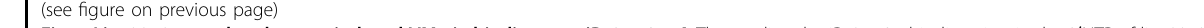
Fig. 5 Linc00707 regulated tumor-induced VM via binding to miR-651-3p. A The predicted miR-651-3p binding sites in the 3 ′ UTR of linc00707 (linc00707-3 ′ UTR-Wt) and the designed mutant sequence (linc00707-3 ′ UTR-Mut) were indicated. Luciferase reporter assay of HEK-293T cells co- transfected with linc00707-3 ′ UTR-Wt or linc00707-3 ′ UTR-Mut and the indicated miRNA. Data are presented as the mean ± SD ( n = 3, each group). **